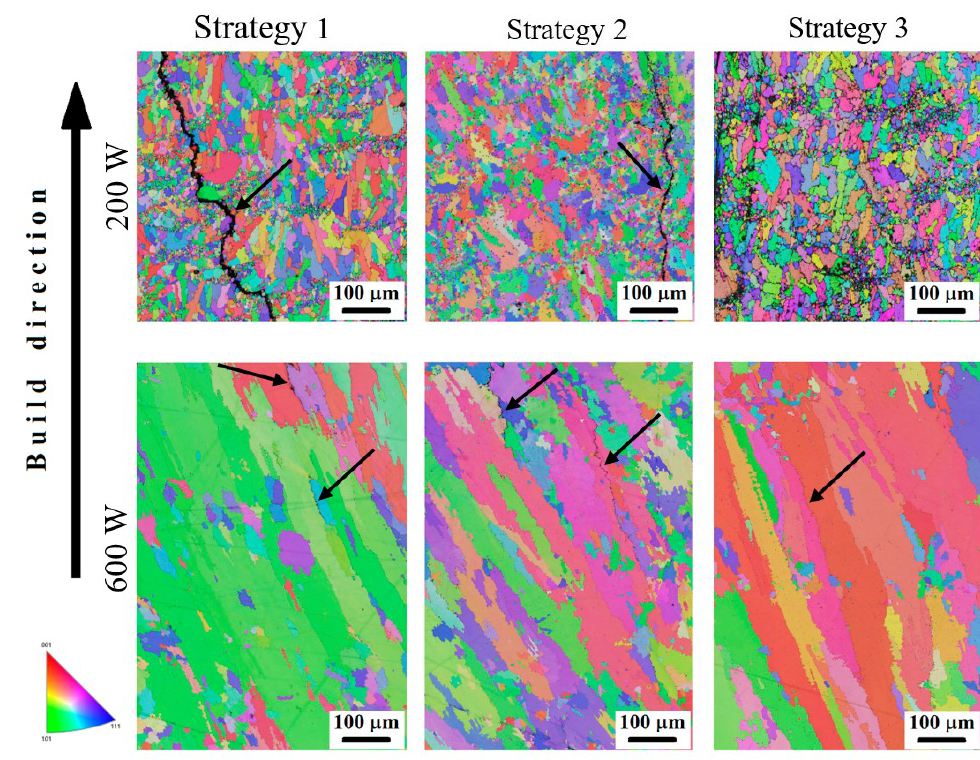
Figure 15. Grain misorientation maps on longitudinal sections of thin walls (arrows indicate